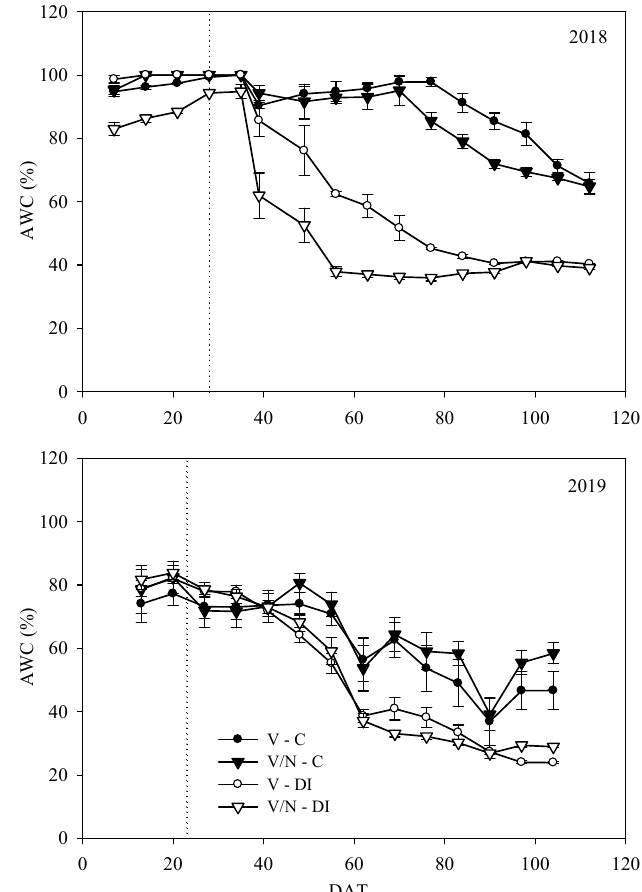
Figure 1. Weekly average soil moisture (expressed as a percentage of the available water content, AWC) during each growing season (2018 and 2019) for plant type, grafted (V/N) and ungrafted (V), and for both irrigation strategies: Control (C) and deficit irrigation (DI). DAT are days after transplanting. The vertical line represents the start of irrigation treatments.